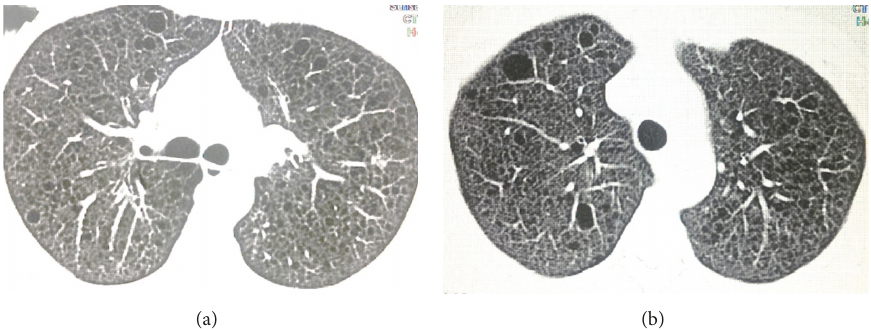
Figure 3: HRCT of the chest, showing diffuse cystic changes distributed equally in all regions of both